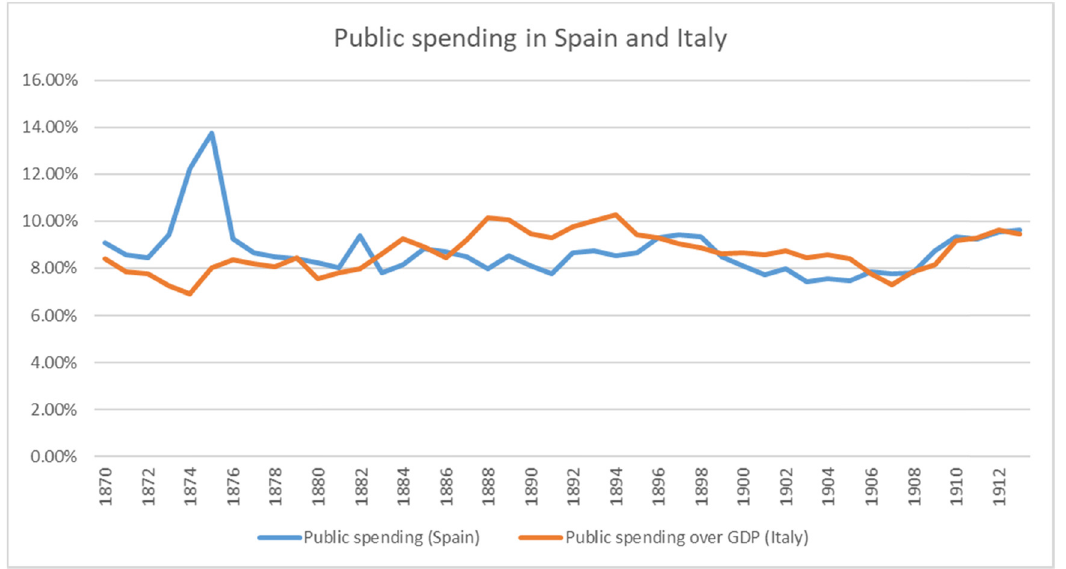
Figure 2: Public spending evolution in Spain and Italy. Sources: Prados de la Escosura ( 2003 ) for Spain and Ba ffi gi ( 2013 ) for